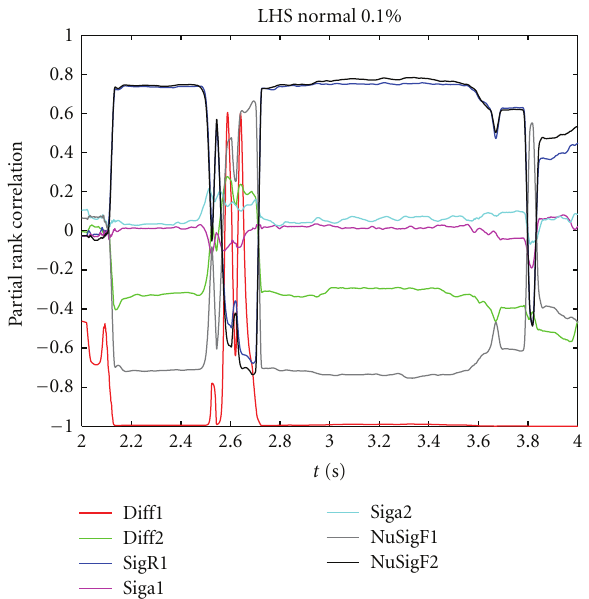
Figure 11: Partial rank correlation coe ffi cient LHS normal 0.1%, output variable:enthalpy.